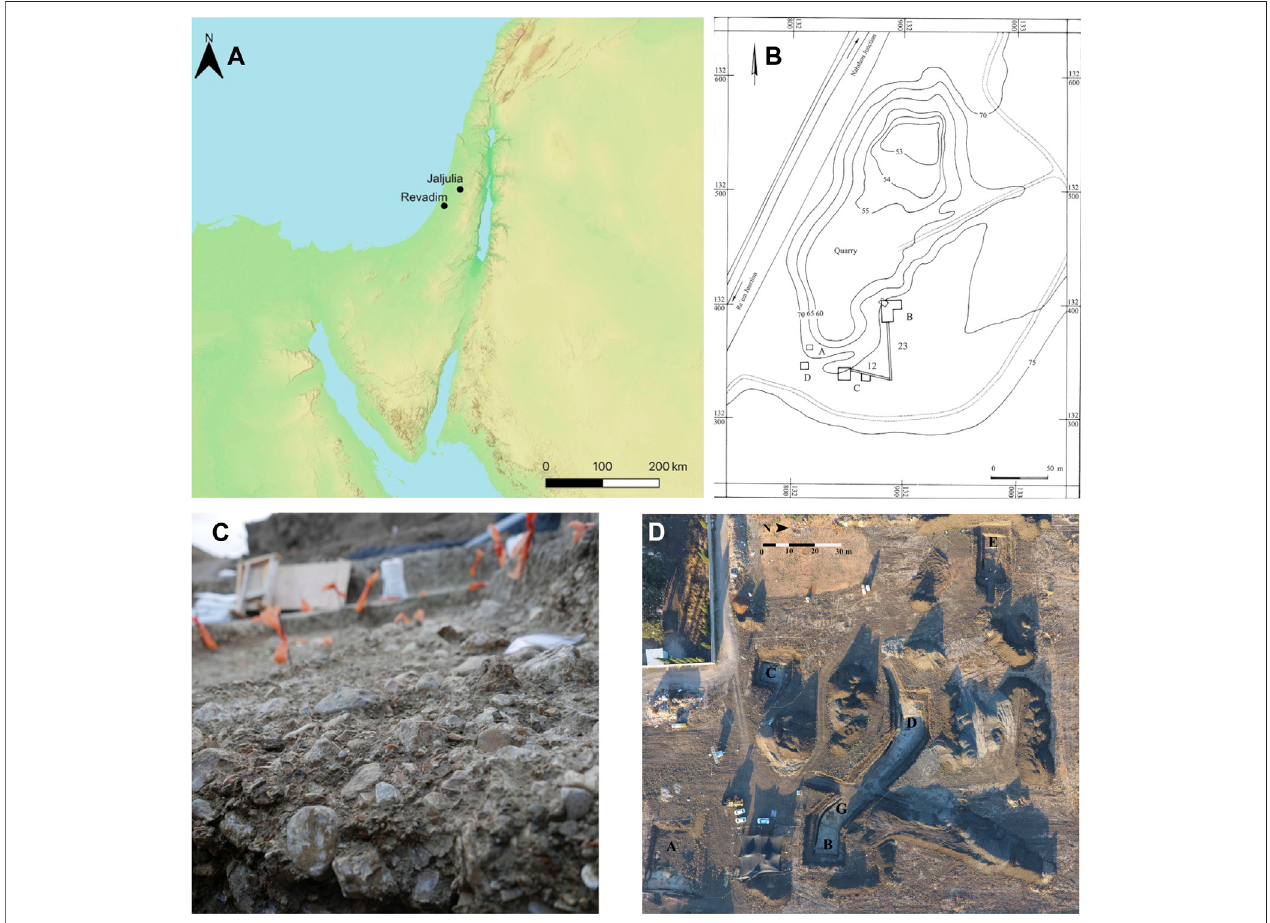
FIGURE1|(A) Locationofthesitesdiscussedinthetext; (B) Revadimsiteareasofexcavation; (C) Aclose-upatthearchaeologicalhorizonofAreaB,Jaljulia.Note the high density of the fl int items; (D) Jaljulia site areas of excavation.